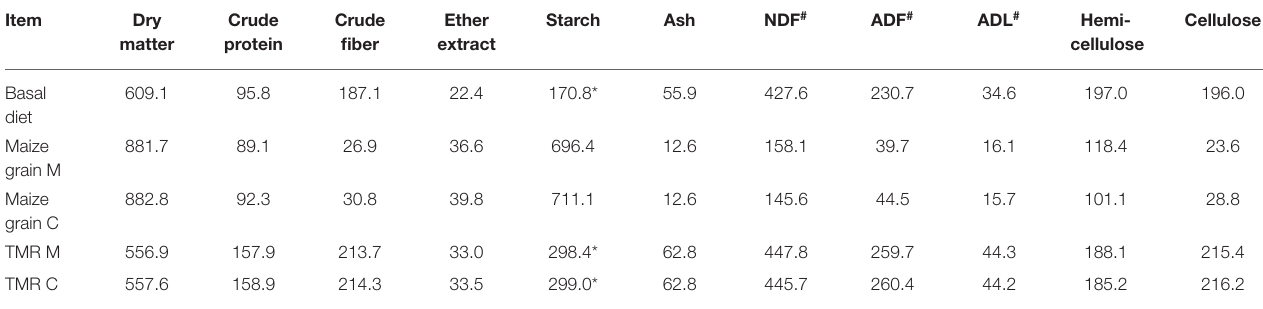
TABLE 1 | Dry matter (g/kg) and chemical analysis (g/kg DM) of the basal diet, maize grains and the associated total mixed ration (TMR)